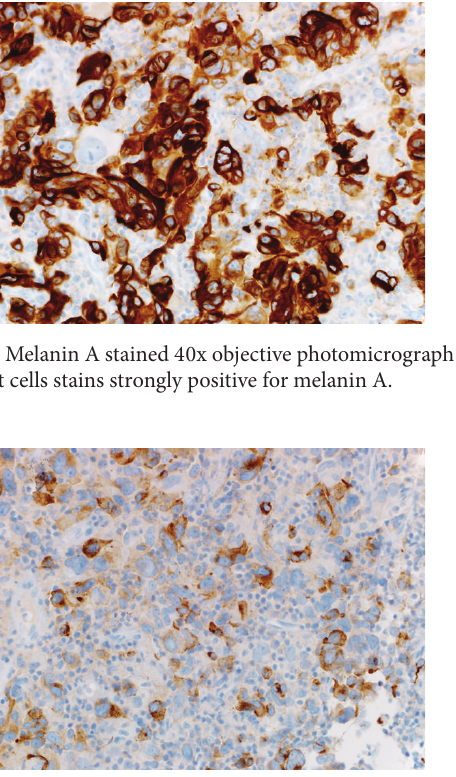
Figure 4: Human melanoma black-45 (HMB-45) stained 40x objective photomicrograph shows malignant cells stains strongly positive for